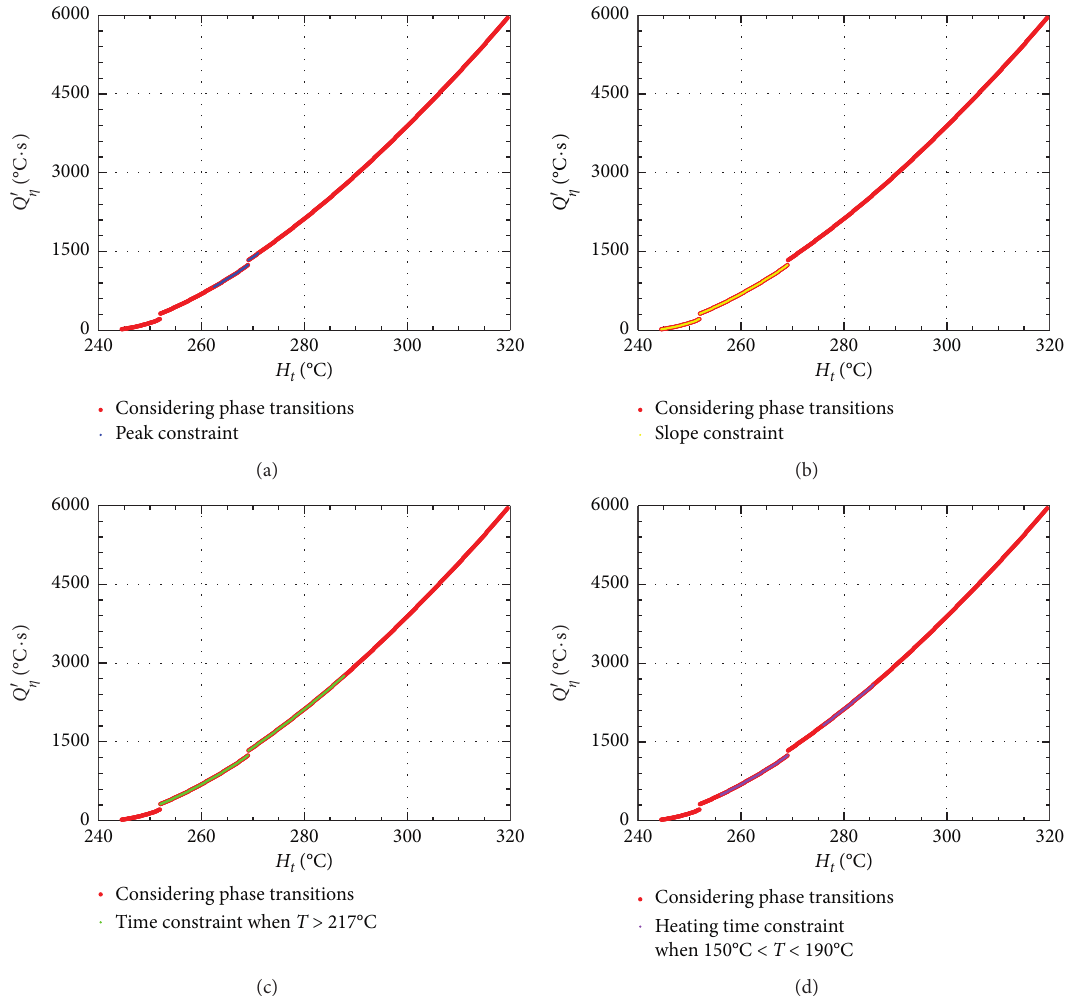
Figure 12: Effects of four process constraints in the range of | Δ H T > 217 ∘ C, and (d) heating time limiting when 150 ∘ C < T < 190 ∘